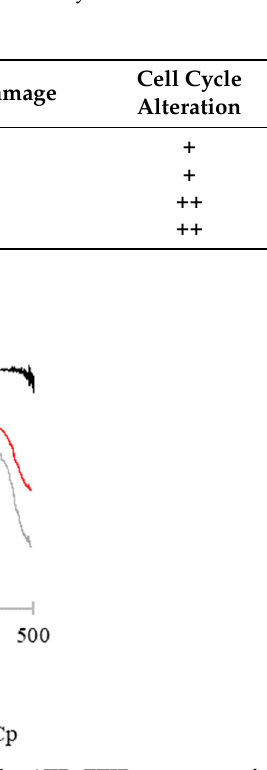
Figure A1. FTIR spectra of the AgHEC NPs. The ATR–FTIR spectrum of the hydroxyethyl cellulose (HEC) functionalized with quaternary ammonium used as capping agent (in red) show a broad band at approximately 3500–3200 cm − 1 , which refers to stretching of hydroxyl group. Peaks at 2870 and 3010 cm − 1 refer to C–H stretching. The band at approximately 1650–1580 cm − 1 is related to the